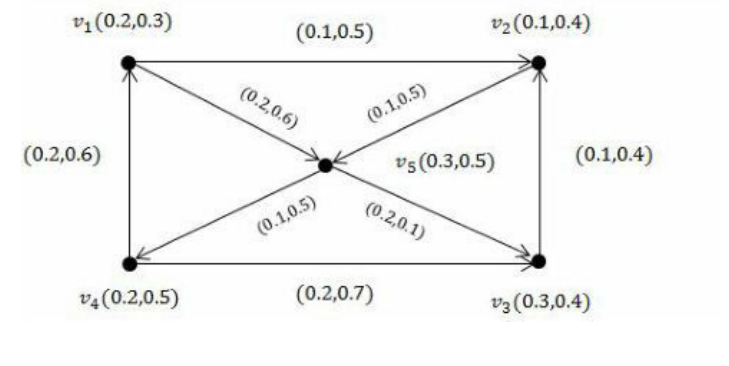
Figure 12. VDG ( G